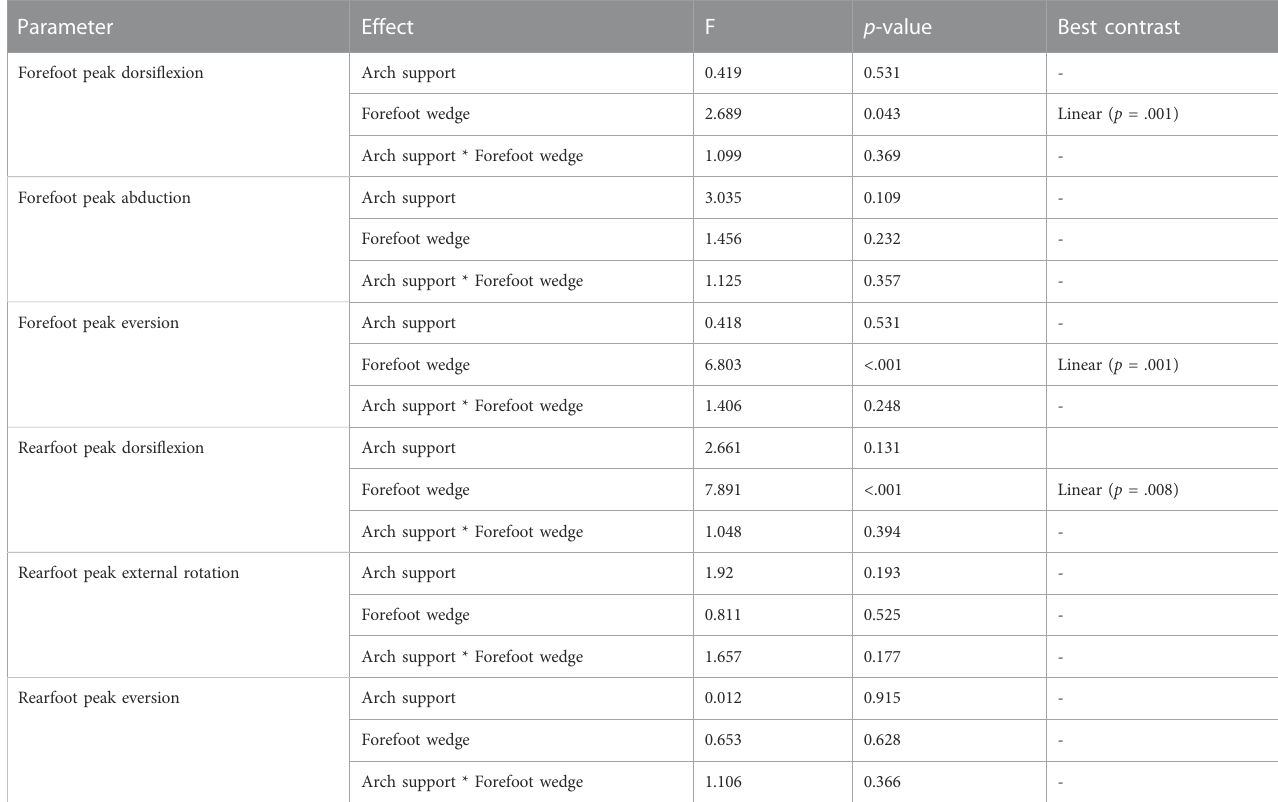
TABLE 1 Results of tests of within-subject effects from two-way ANOVAs. Parameter